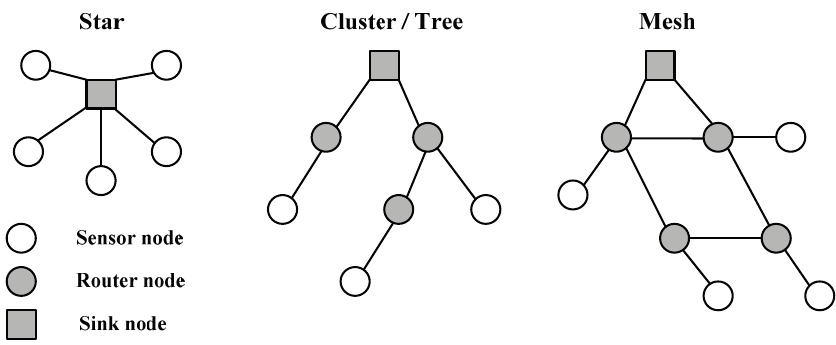
Figure 3. General WSN network